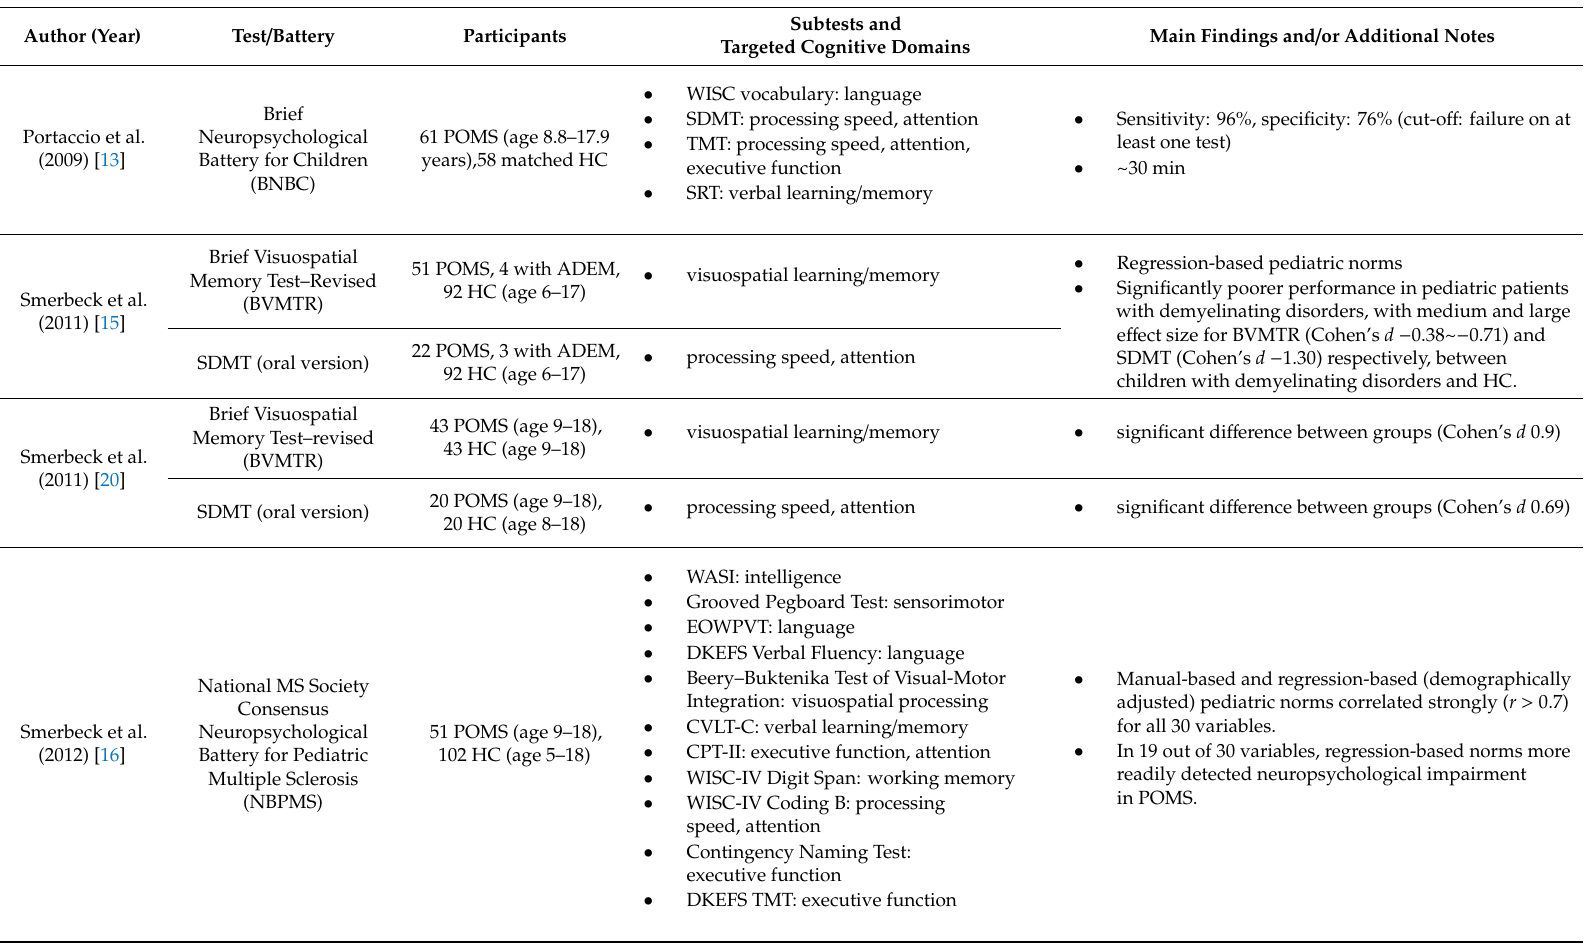
Table 1. Overview of studies evaluating instruments for cognitive assessment for pediatric-onset multiple sclerosis